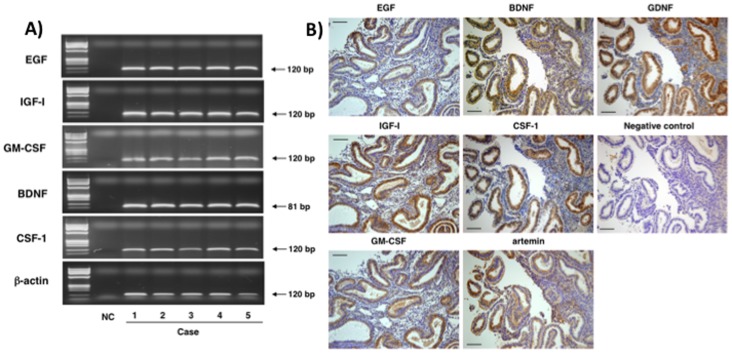
Expression of key growth factors in human endometrium.Human endometrial samples were obtained from five different patients at the secretory phase of their cycle. A) Gel electrophoretic analyses of RT-PCR products for different growth factors. Arrows indicate the expected sizes of the amplified PCR products. bp: base pair, B) Immunostaining analyses of growth factor expression in human endometrium. Brown signals for growth factors (EGF, IGF-1, GM-CSF, BDNF, CSF-1, artemin, and GDNF) were found following staining with specific antibodies. Negative controls were incubated with nonimmune IgG. Bar = 100 µm.